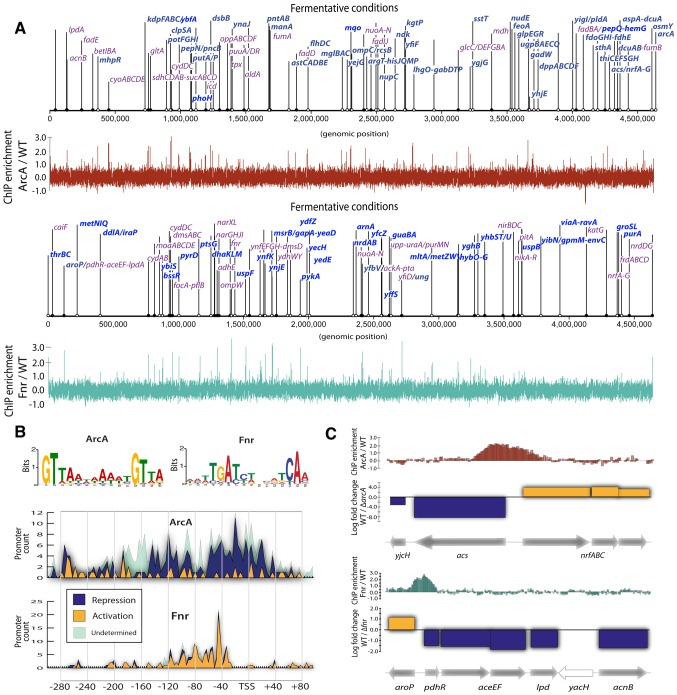
ChIP-chip reveals hundreds of new binding regions and regulatory mechanisms.(A) Triplicate averaged tracks of ChIP-chip intensity plotted along the length of the genome for ArcA and Fnr under fermentation. We show 83% of previously reported regulatory regions are confirmed (purple) and 132 binding regions (bright blue) are newly discovered relative to RegulonDB. All discovered peaks are shown and operon names included when ChIP peaks also corresponded to differential gene expression for a given operon. (B) Binding motifs are recovered from ChIP binding sites. Histograms of the frequency of motif occurrence relative to the transcription start site (TSS) are plotted and overlaid with gene expression data to reveal ArcA repression via blocking of the −35 box and Fnr activation via upstream binding at −41.5. (C) Transcription factor mediated bi-directional transcription is observed in which a single binding region is shown to regulate divergently transcribed transcriptional units.